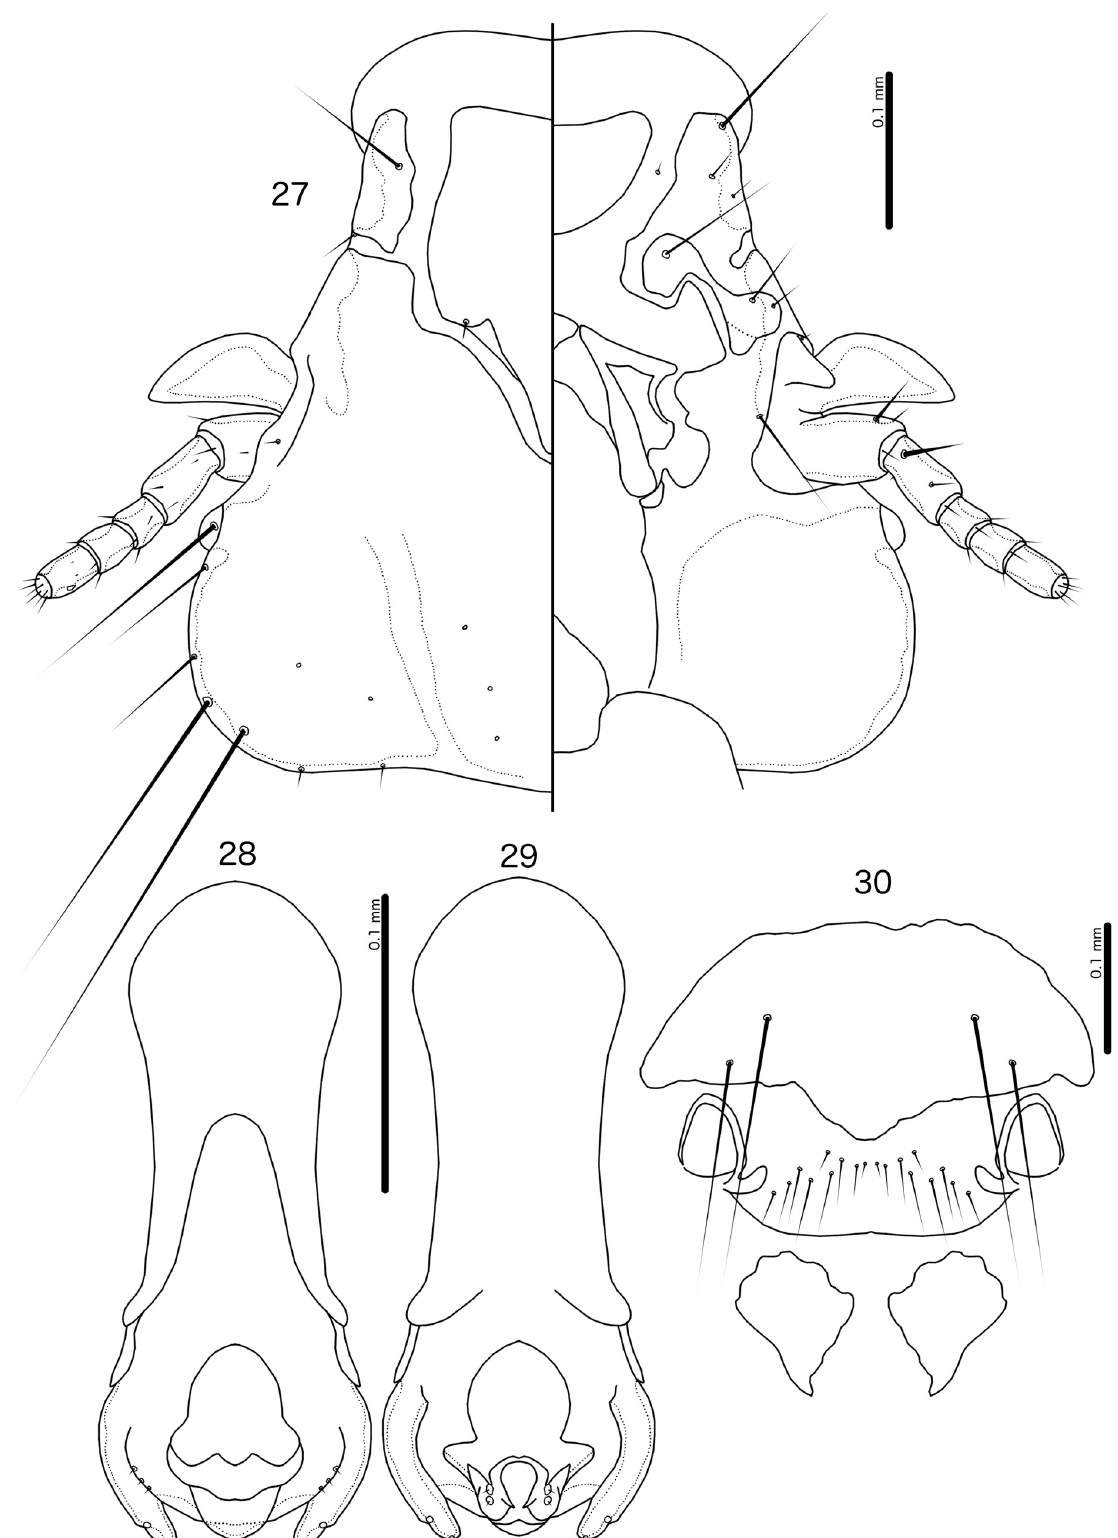
Figs 27–30. Philopterus trepostephanus sp. nov. ex Tephrodornis virgatus fretensis Robinson & Kloss, 1920. 27 . Male head, dorsal and ventral views. 28 . Male genitalia, dorsal view. 29 . Male genitalia, ventral view. 30 . Female subgenital plate, vulval margin, and subvulval plates, ventral